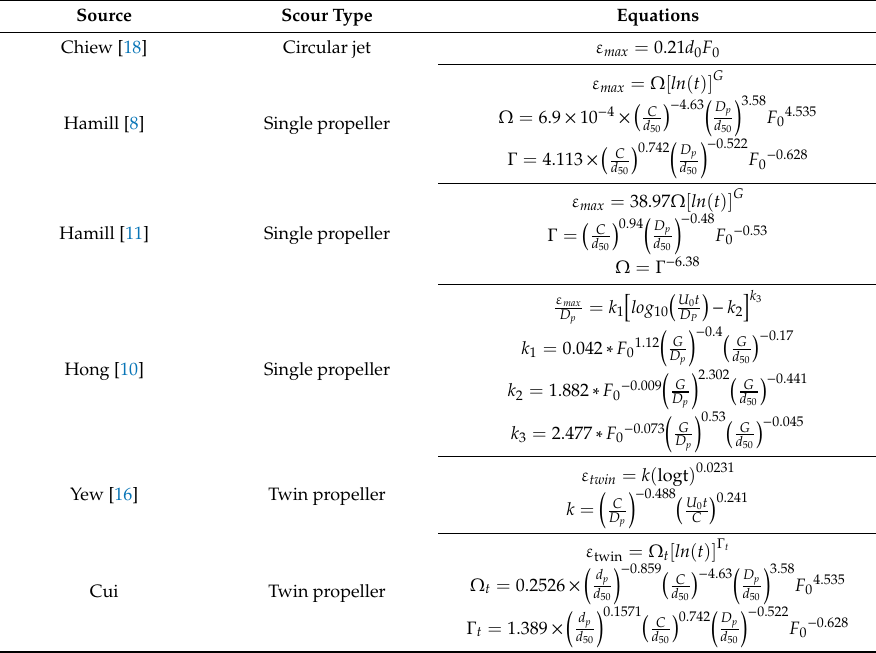
Table 1. Summarised scour depth induced by the